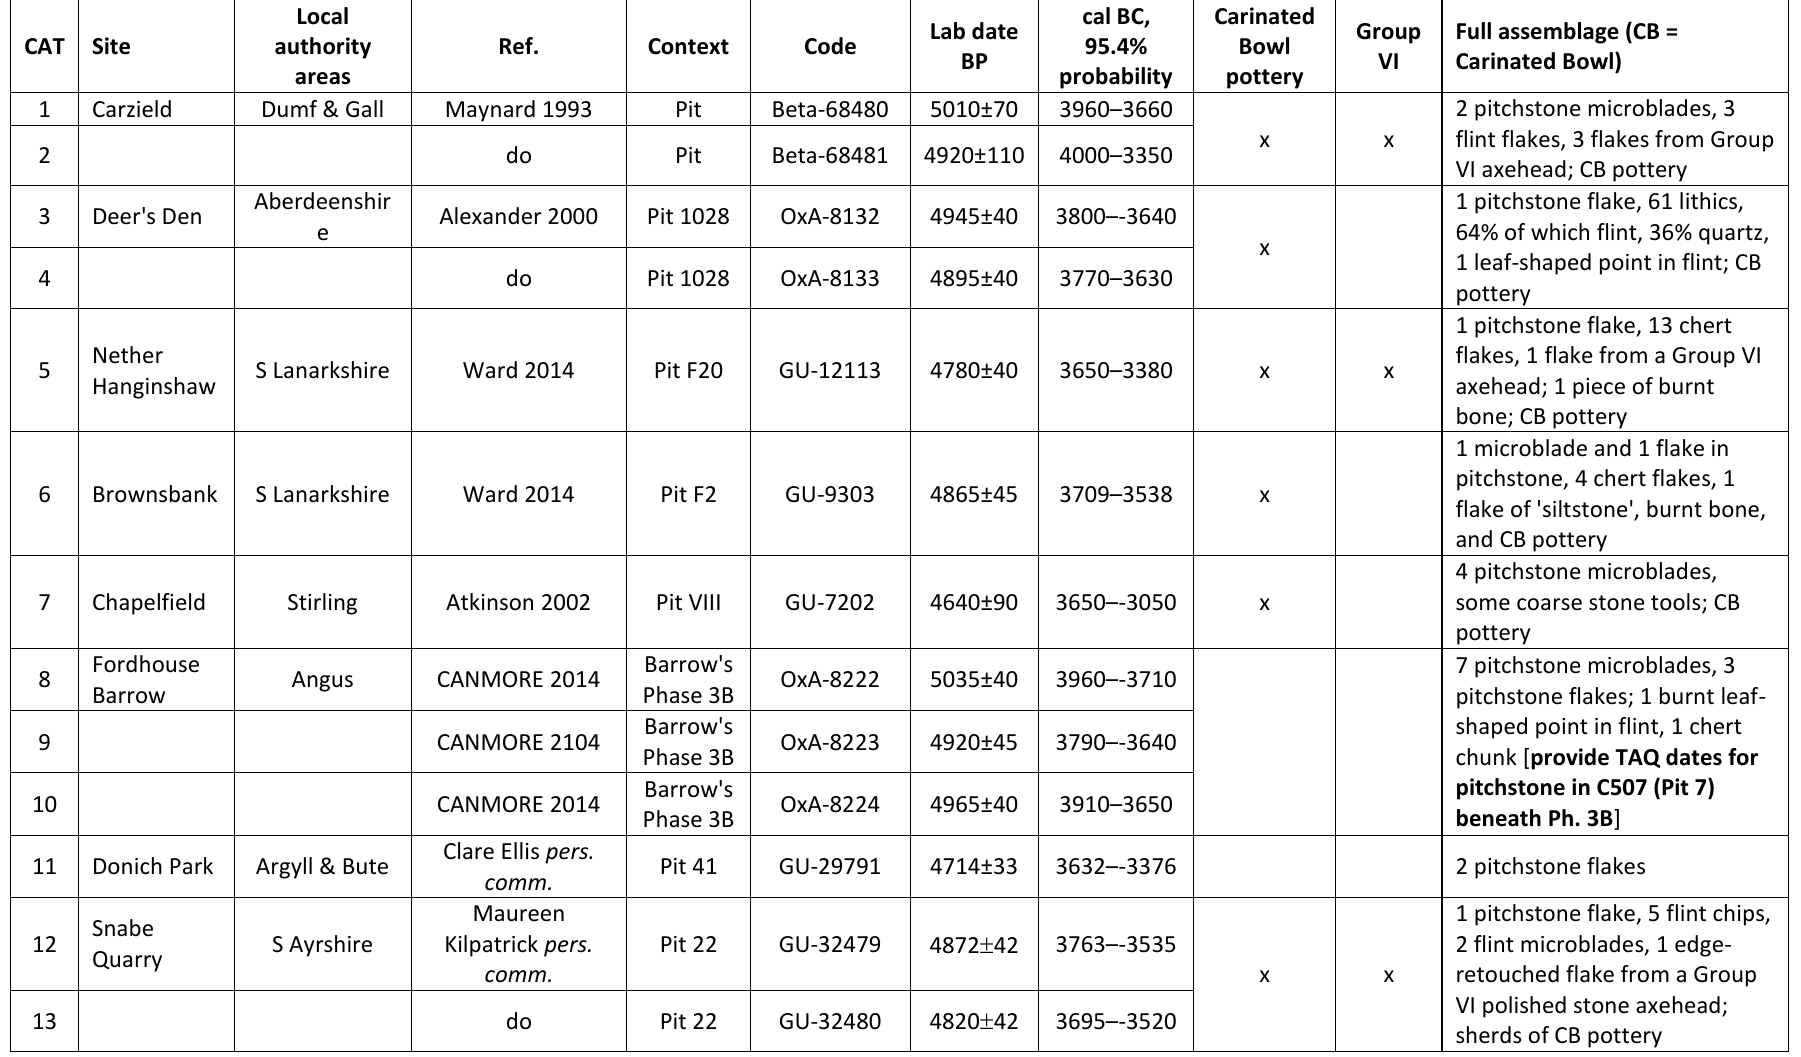
Table 1. Radiocarbon-dated pits containing worked pitchstone, plus details of the radiocarbon dates that provide a taq for pitchstone use at Fordhouse Barrow.